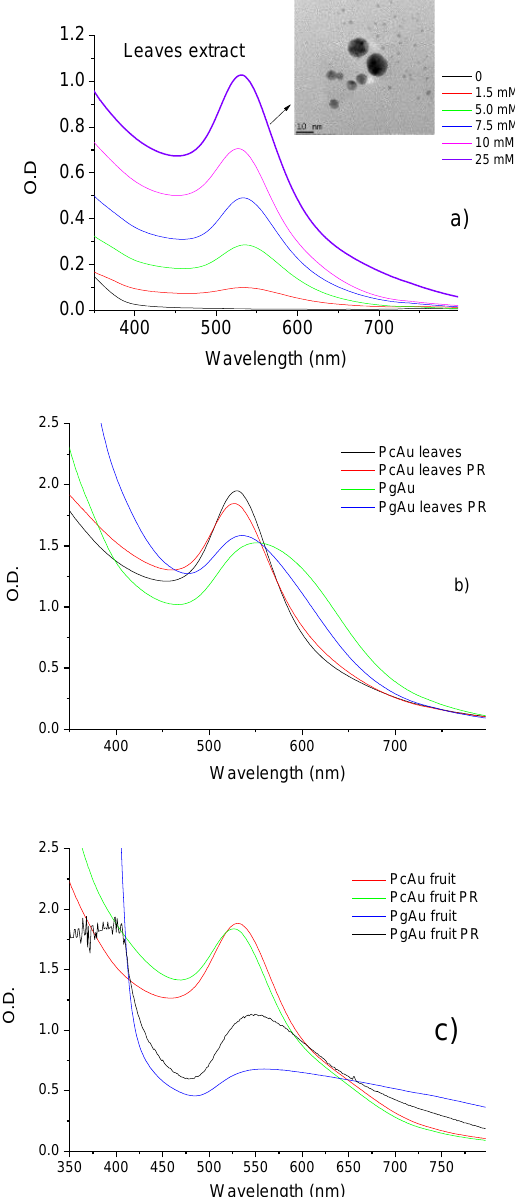
Figure 5. ( a ) PcAuNPs prepared with leaf extract SPR in the function of HAuCl 4 concentration. TEM images PcAuNP. PcAuNPs and PgAuNPs prepared with photoreduction and pH 7.0. ( b ) leaf extract, and ( c ) fruit extract.